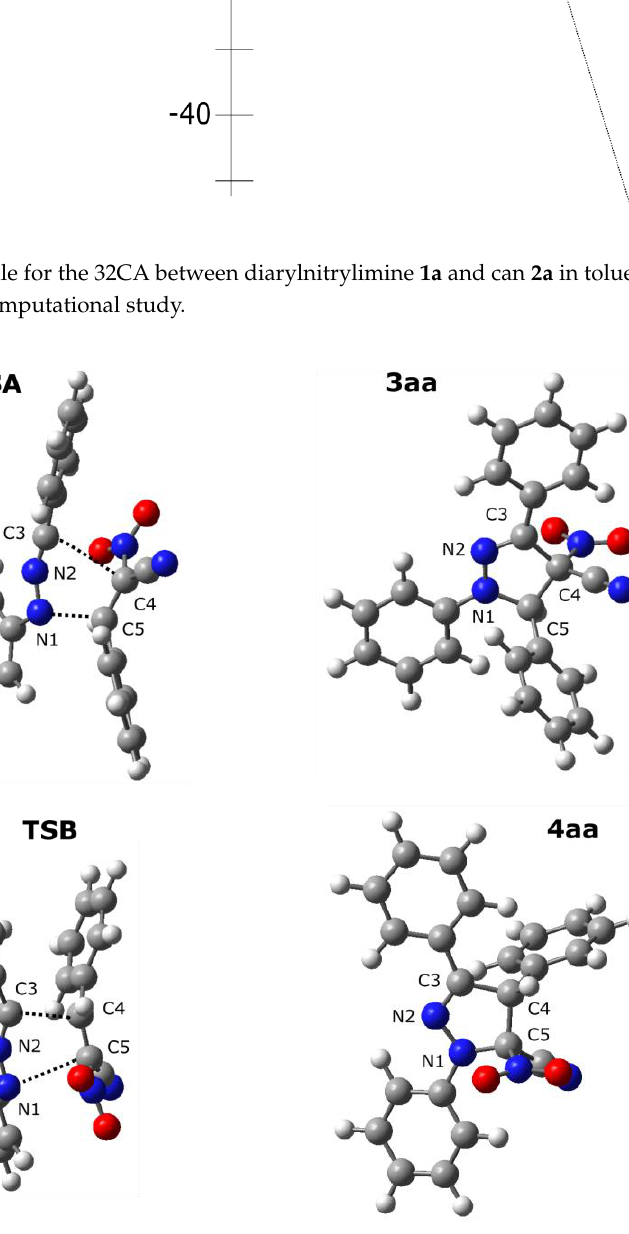
Figure 3. Views of key structures for the 32CA between diarylnitrylimine 1a acanACN 2a in toluene solution according to the DFT computational study.